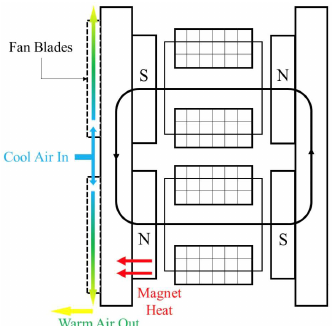
Figure 19. Configuration of an axial flux permanent magnet machine with a centrifugal fan attached on the rotor [46].